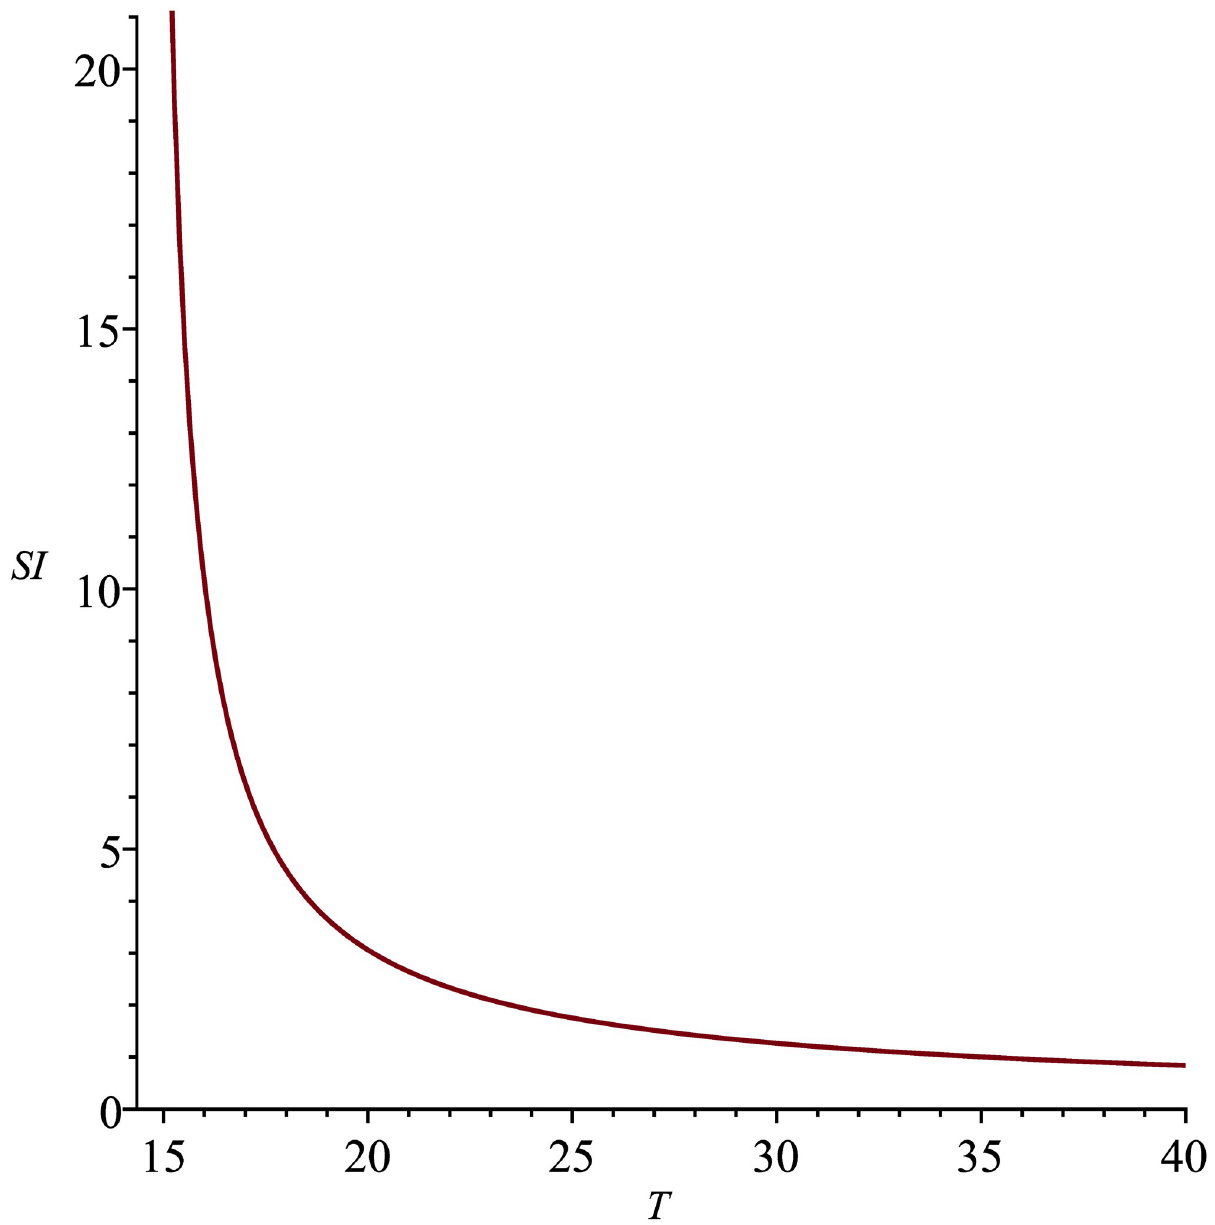
Fig 2. Sensitivity index Ω R 0